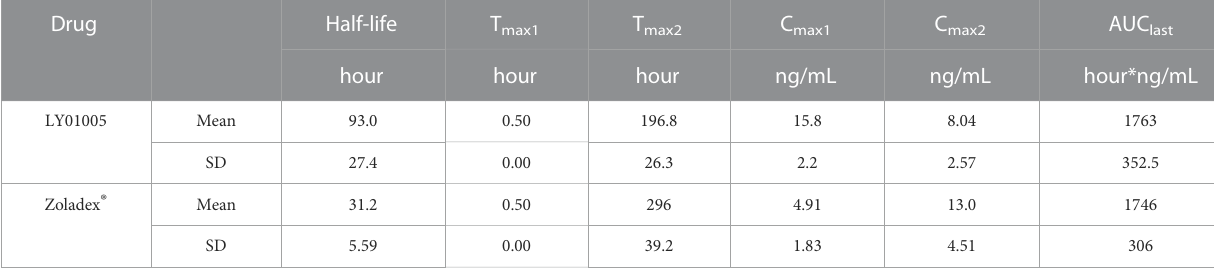
TABLE 3 Mean pharmacokinetic parameters of LY01005 and Zoladex ® in rats. Drug